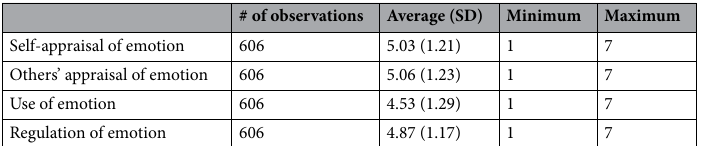
# of observations Average (SD) Minimum